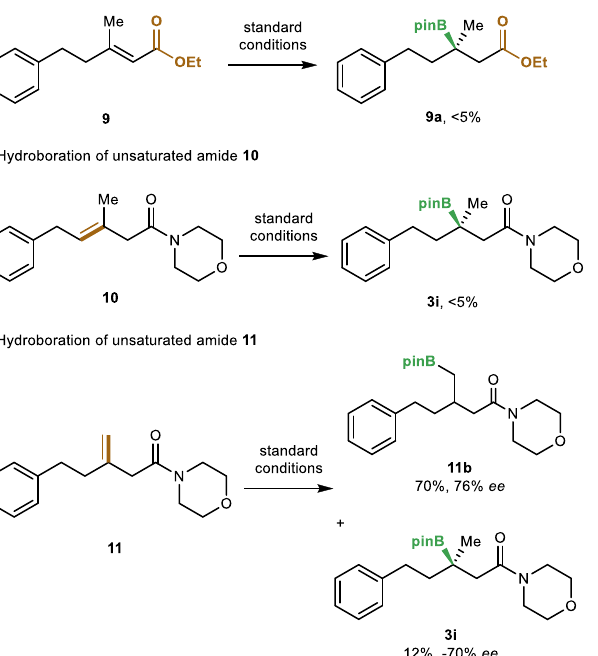
Fig. 5 Control experiments. a Hydroboration of unsaturated ester 9 . b Hydroboration of unsaturated amide 10 . c Hydroboration of unsaturated amide 11 .